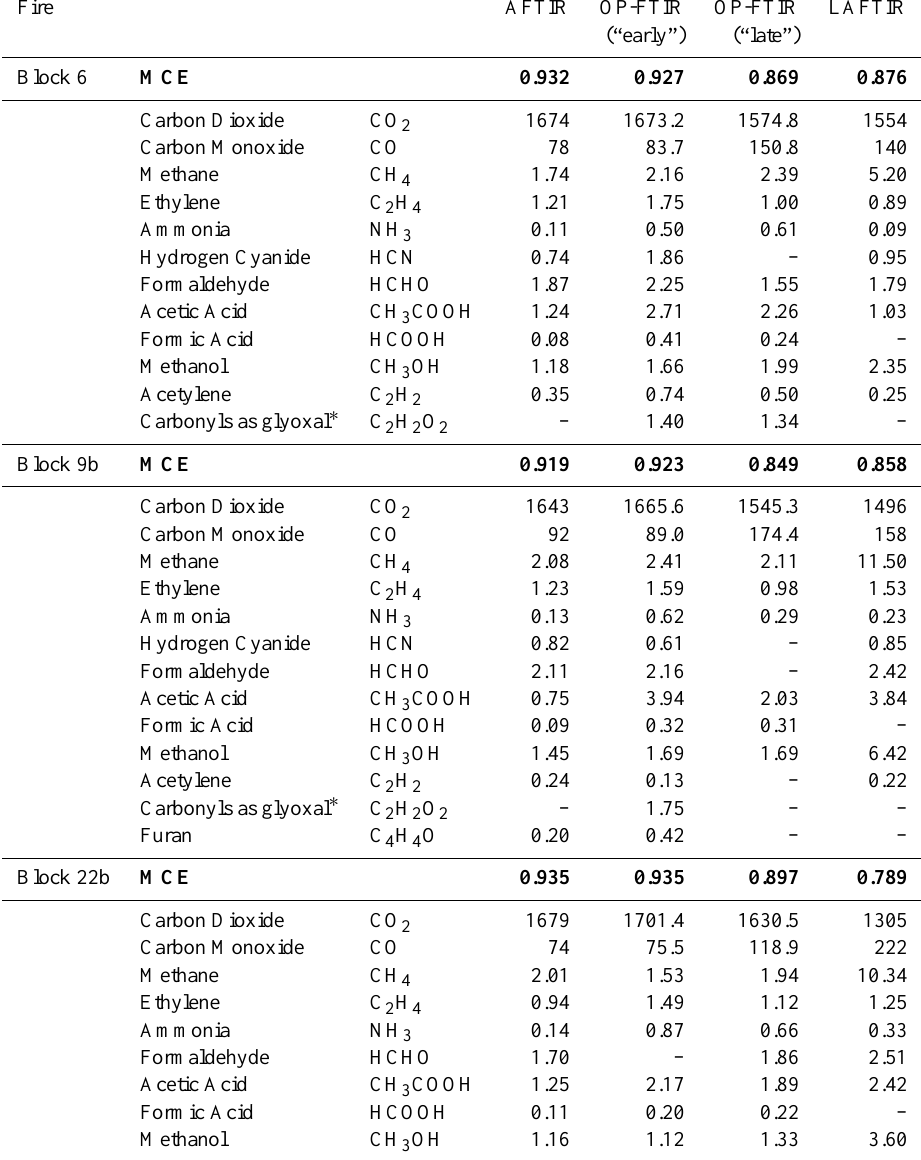
Table 2. MCE (bolded) and EFs (gkg − 1 ) for select compounds measured during “early” and “late” blocks by OP-FTIR. Fire-averaged EF from the AFTIR and LAFTIR (Akagi et al., 2013) are also